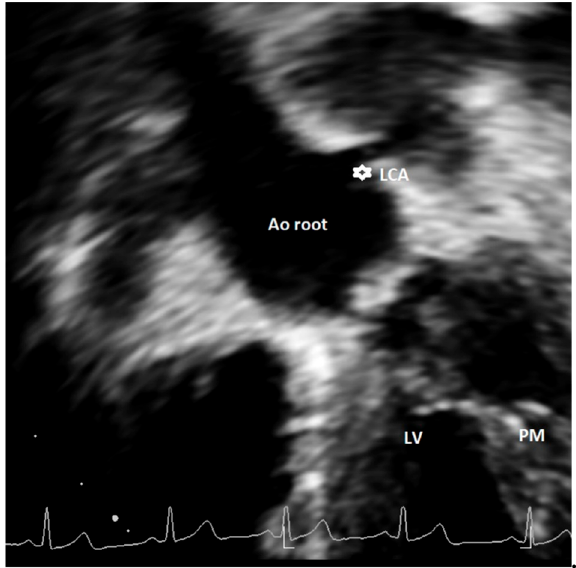
Figure 4. Modified apical 5-chamber view showing high take-off of left coronary artery (asterisk). This is a case of an asymptomatic 14-year-old female, with incidental diagnosis of bicuspid aortic valve. Ao = aorta, LCA = left common coronary artery, LV = left ventricle; PM = papillary muscle.